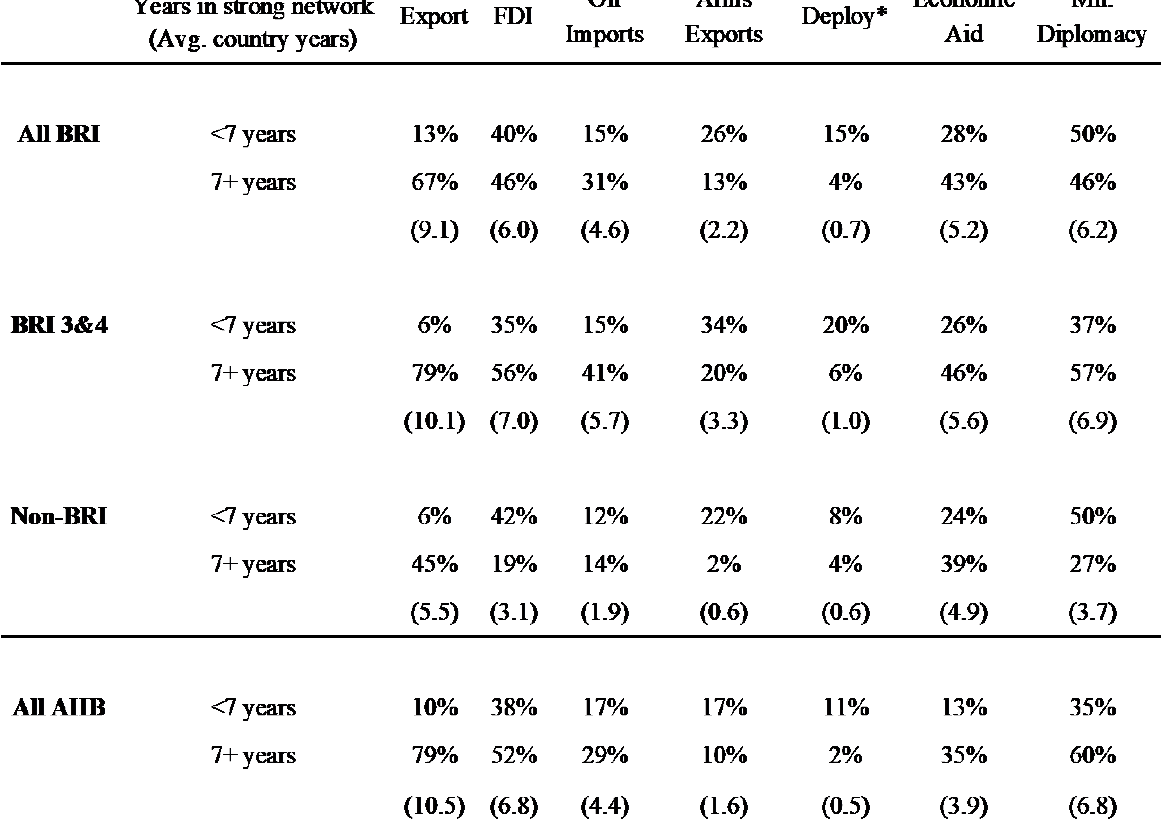
Table 4: Proportion of countries in strong networks, 2000 - 2012, receiving Belt and Road Investments or investing in